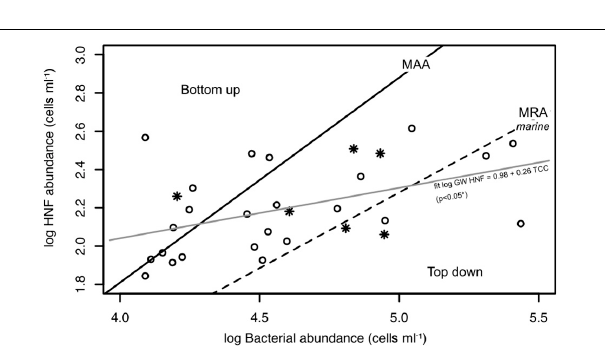
FIGURE 5 | The assessment of top-down vs. bottom-up control of HNF abundance Log-log plot of the abundance of prokaryotes and heterotrophic nanoflagellates (HNF) in the groundwater ( ◦ ) samples from the river ( ∗ ) were added to the graph for comparison. MAA, maximum attainable HNF abundances max log 10 HNF = − 2.47 + 1.07 log 10 TCC ; MRA, mean realized abundances intercept = − 1.67, slope = 0.79; determined by Gasol